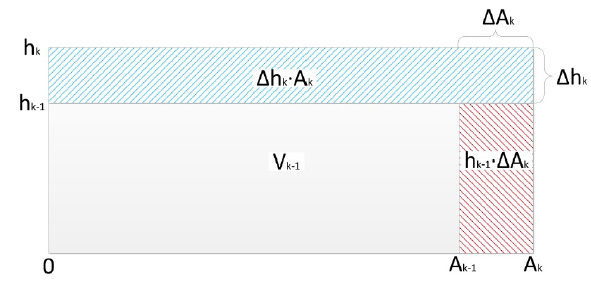
Figure 2: Schematic figure of the volume of the metal pad, showing change in volume of the molten metal described by the variables A and h